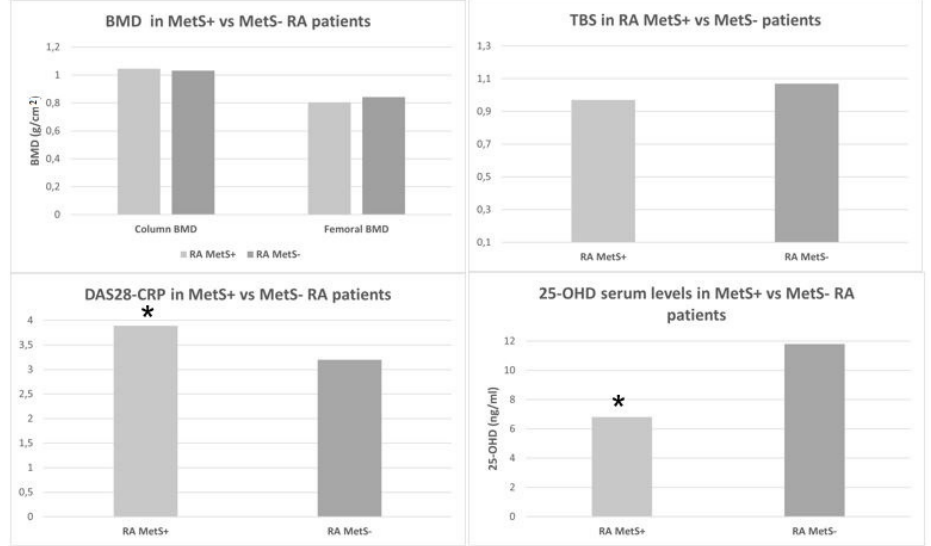
Figure 1. Median values of BMD, TBS, DAS28-CRP, and 25-OHD serum levels in MetS+ vs. MetS − RA patients. The difference between the DAS28-CRP and 25-OHD (*) serum levels in the two subgroups were statistically significant and were p = 0.04 and p = 0.01, respectively. For abbreviations, see the legend of Table 1. Table 2. Clinical, metabolic, and bone parameters of the MetS+ versus MetS − RA patients.